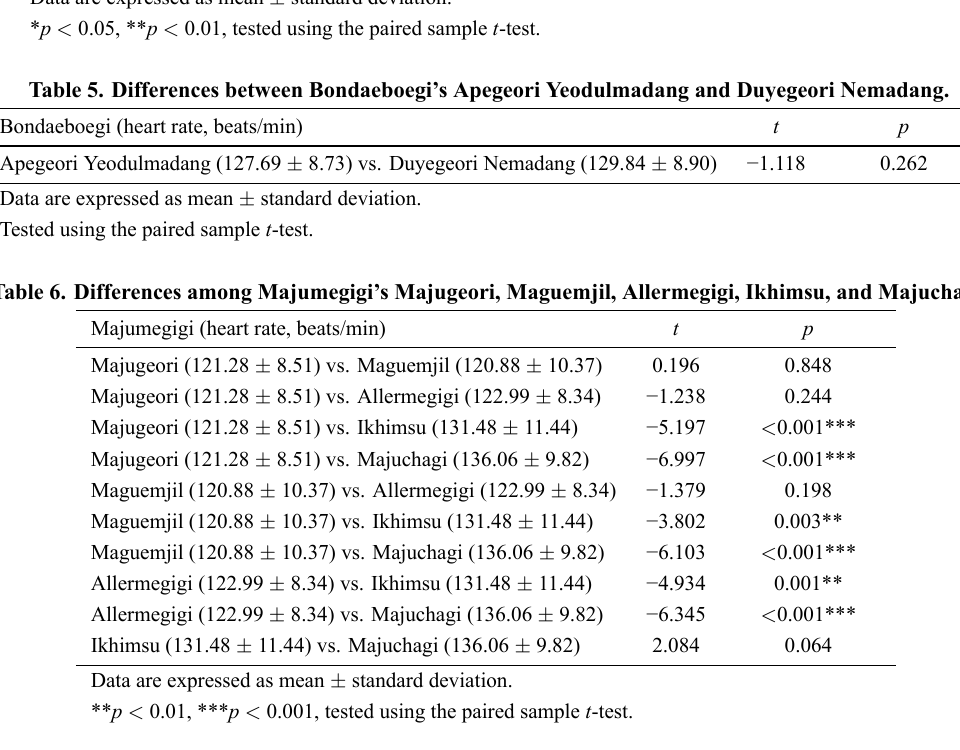
Table 7. Differences among Honjayikhigi, Bondaeboegi, and Majumegigi training movements. Heart rate (beats/min)